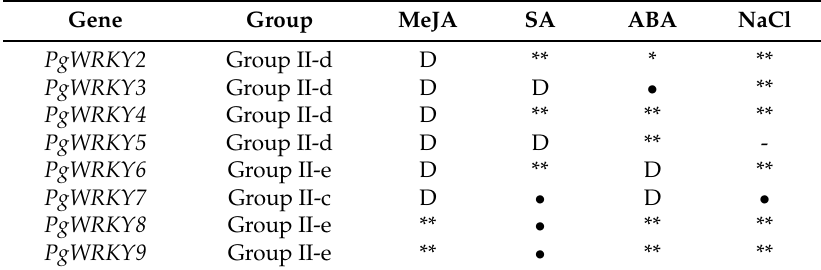
Table 1. Expression profiles of the eight analyzed PgWRKYs ( PgWRKY2-9 ) under various treatments. Gene Group MeJA SA ABA NaCl PgWRKY2 Group II-d D ** * ** PgWRKY3 Group II-d D D ‚ ** PgWRKY4 Group II-d D ** ** ** PgWRKY5 Group II-d D D ** - PgWRKY6 Group II-e D ** D ** PgWRKY7 Group II-c D ‚ D ‚ PgWRKY8 Group II-e ** ‚ ** ** PgWRKY9 Group II-e ** ‚ **